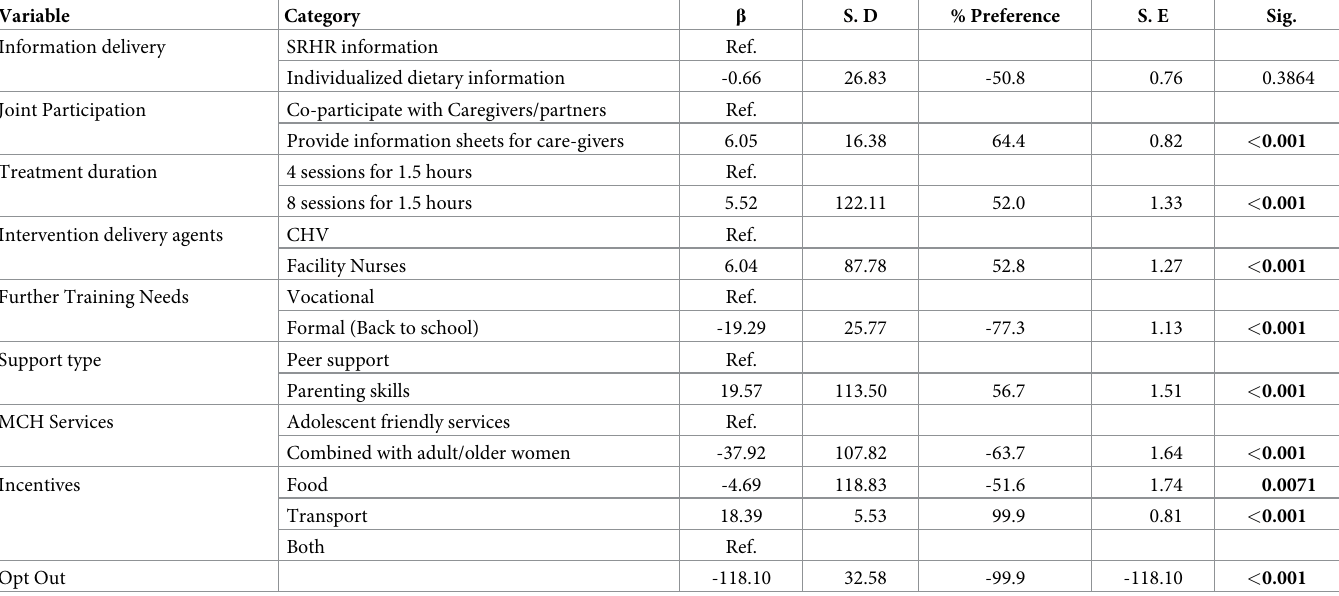
Table 3. Results of mixed multinomial logit model with calculated proportions of positive and negative effects for treatment